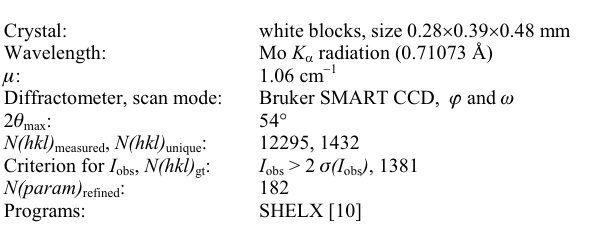
Table 1. Data collection and handling.